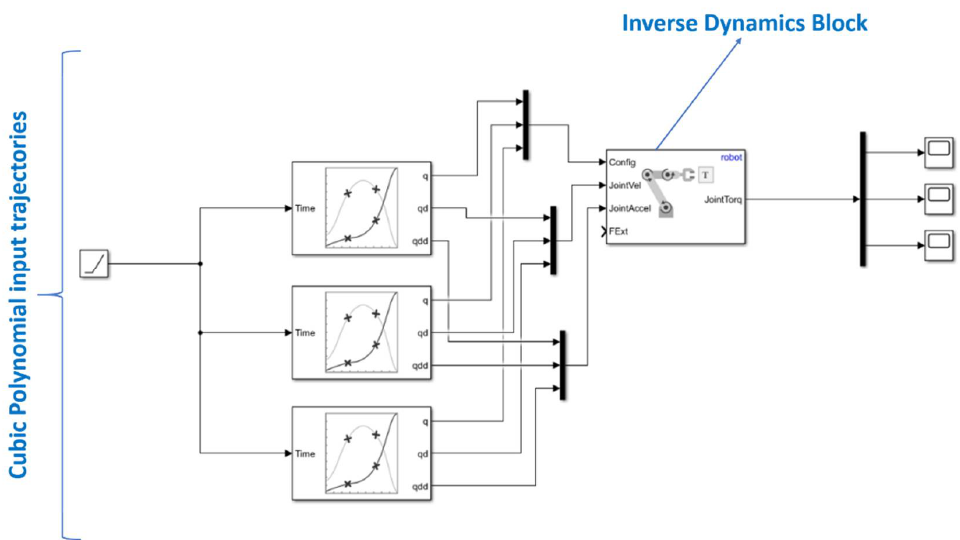
Figure 10. Inverse dynamics model of SAMA exoskeleton. Three polynomial signals of the third order were the input for the inverse dynamics block, as shown in Figure 11. The peak and RMS torque values for the exoskeleton joints were calculated by assuming that the maximum joint velocity is 90 °/s.